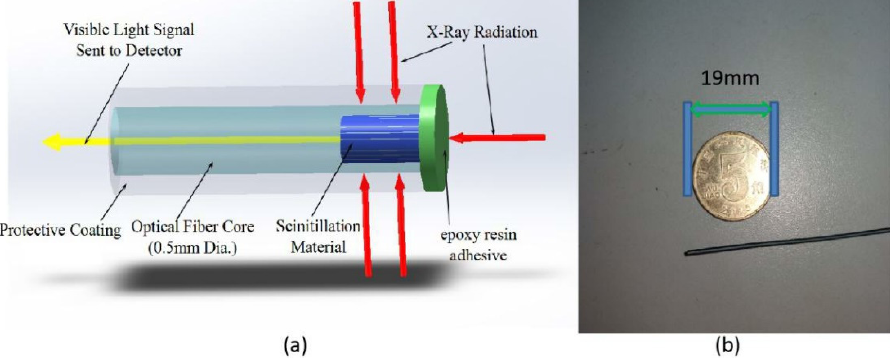
Figure 23. ( a ) Schematic representation of a scintillating-based fiber optic dosimeter and ( b ) the photograph with dimensions comparison [201].